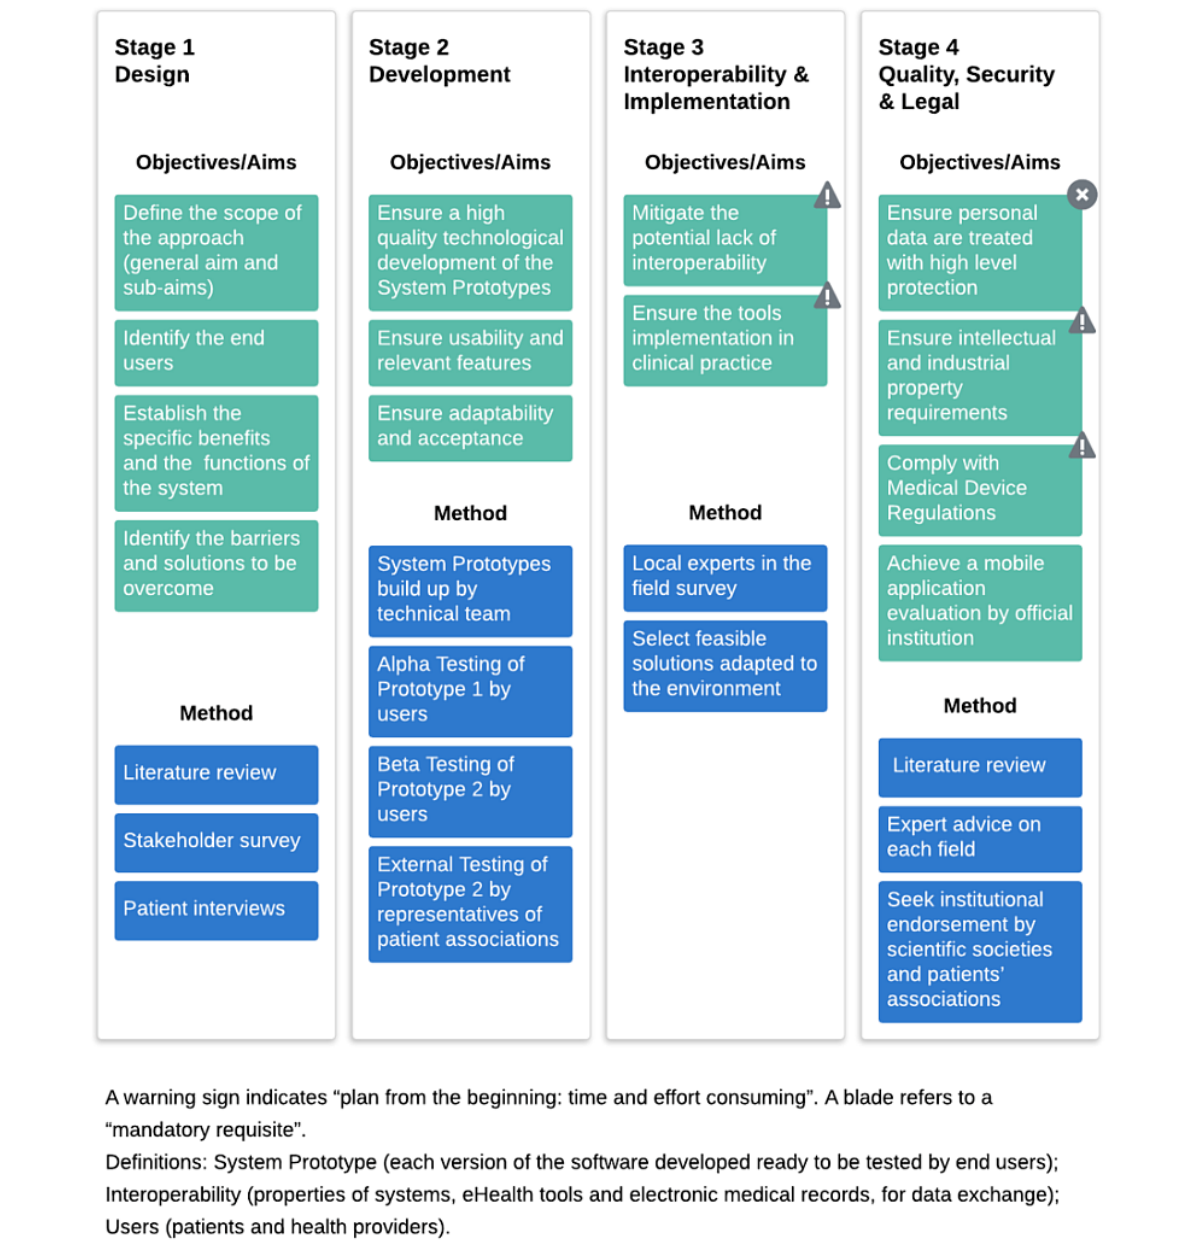
Figure 2. Summary of the procedures and stages followed during implementation of the mHeart